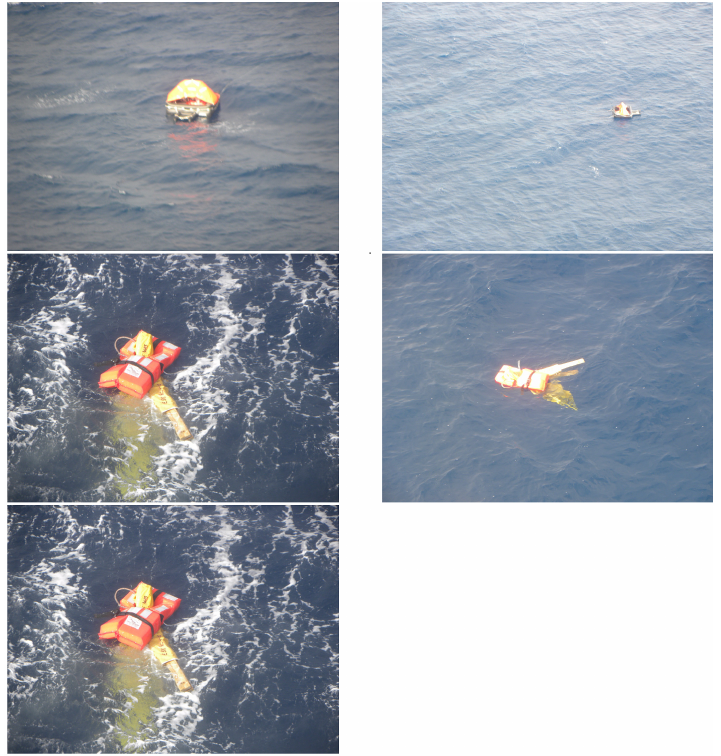
Figure 9. Photos of the dummy (Calabria#1) and raft (Calabria#2) used by Italian Coast Guard in the Calabria exercise.